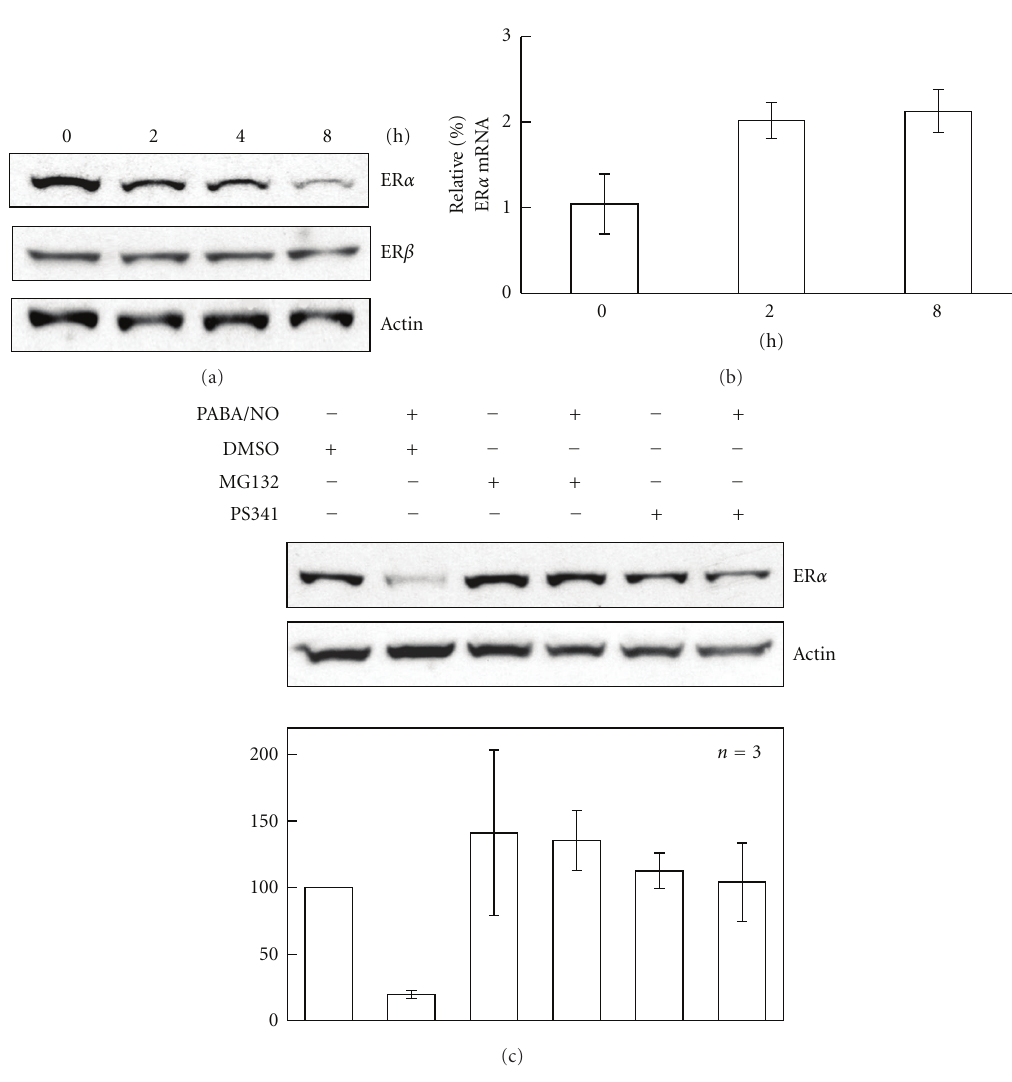
Figure 4: PABA/NO leads to ER α proteasomal degradation. (a) MCF7 cells were treated with DMSO or 20 μ M PABA/NO for the indicated times. Cell lysates (40 μ g) were subjected to Western blot with the indicated antibodies. (b) MCF7 cells were treated with DMSO or 20 μ M PABA/NO for the indicated times. (c) MCF7 cells were pretreated with proteasome inhibitors MG132 (1 μ M) or PS341 (10 μ M) for 2h and then treated with 20 μ M PABA/NO for 6h. Cell lysates (40 μ g) were subjected to Western blot with the indicated antibodies. Bar diagram showed the means and standard deviations determined from three independent